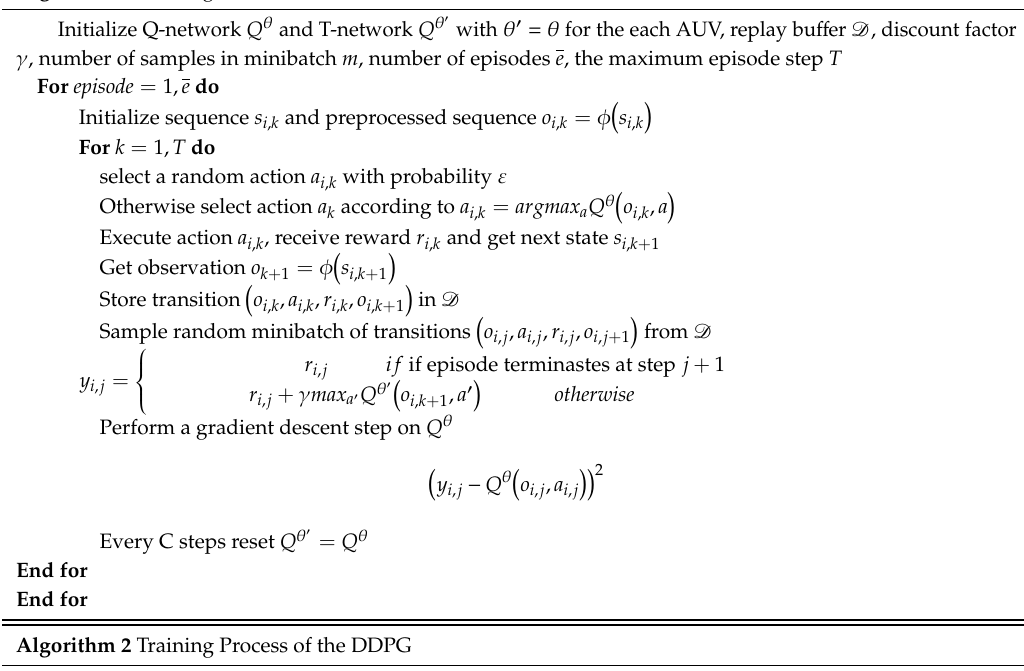
Algorithm 1 Training Process of the DQN